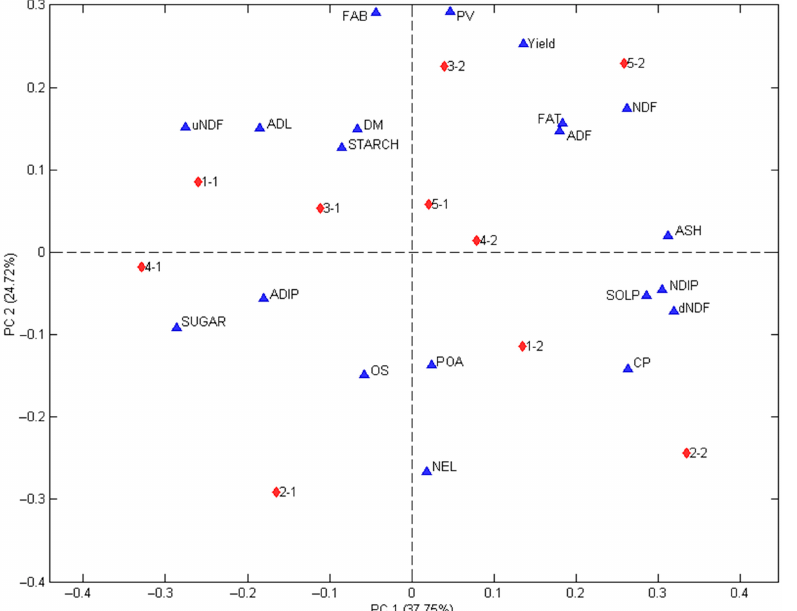
Figure 3. Biplot of Principal Component Analysis of the harvests carried out in 2017 and 2018. Farm × year combinations were named as follows (Farm–Year): 1-1 = Farm 1 in 2017, 1-2 = Farm 1 in 2018, 2-1 = Farm 2 in 2017, 2-2 = Farm 2 in 2018, 3-1 = Farm 3 in 2017, 3-2 = Farm 3 in 2018, 4-1 = Farm 4 in 2017, 4-2 = Farm 4 in 2018, 5-1 = Farm 5 in 2017, 5-2 = Farm 5 in 2018. The studied parameters were as follows: ADF = acid detergent fiber, ADIP = acid detergent-insoluble protein, ADL = acid detergent lignin, ASH = ash content; CP = crude protein content, DM = dry matter, dNDF = digestible NDF evaluated after 24 h of in situ rumen incubations, FAB = number of Fabaceae plants per transect, FAT = fats content, POA = number of Poaceae plants per transect, NDIP = neutral detergent-insoluble protein, NDF = neutral detergent fiber with α -amylase, sodium sulfite, and correcting for ash contamination, NEL = net energy for lactation, OS = number of plants belonging to ‘other species’ per transect, PV = pastoral value, SOLP = soluble protein, STARCH = starch content, SUGAR = sugars content, uNDF = undigested NDF after 240 h of in situ rumen incubations, Yield = grassland yield.